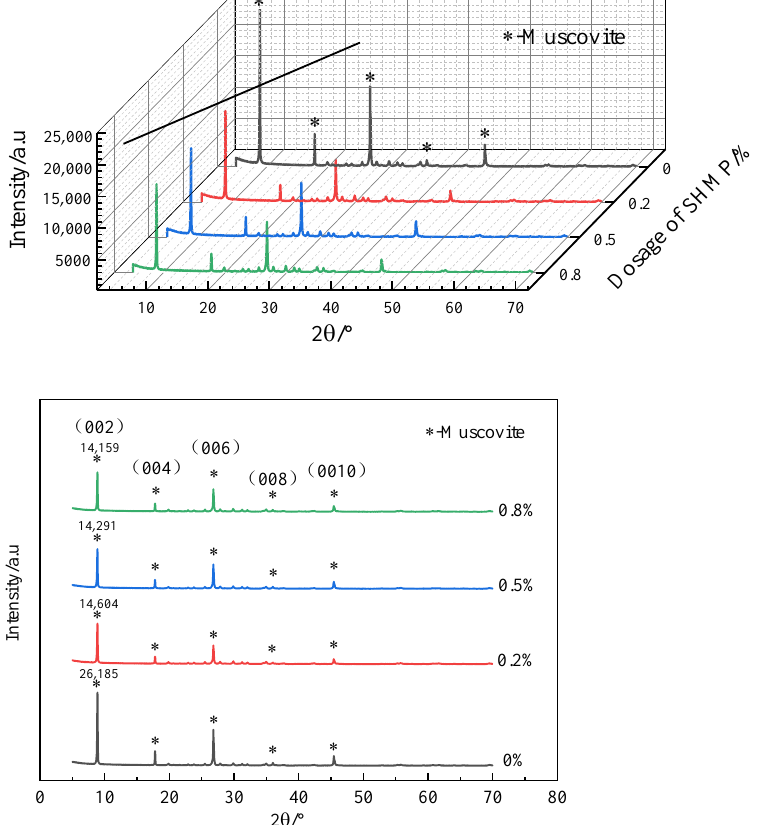
Figure 4. XRD analysis of muscovite products under different dosages of sodium hexametaphos- phate (SHMP).